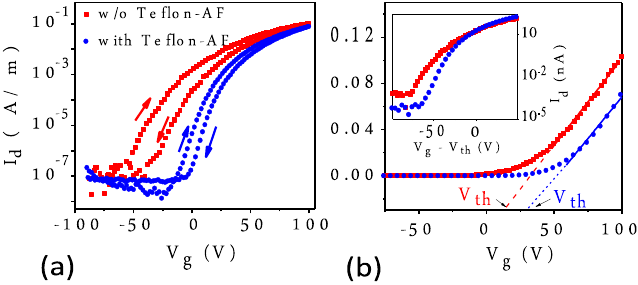
Figure 3. Transfer characteristics of representative FETs before ( a ); and after ( b ) applying Teflon ‐ AF. The y ‐ axis is I d in nA unites for both cases and the dotted lines are visual guides emphasizing the V th shift after applying the polymer cap.